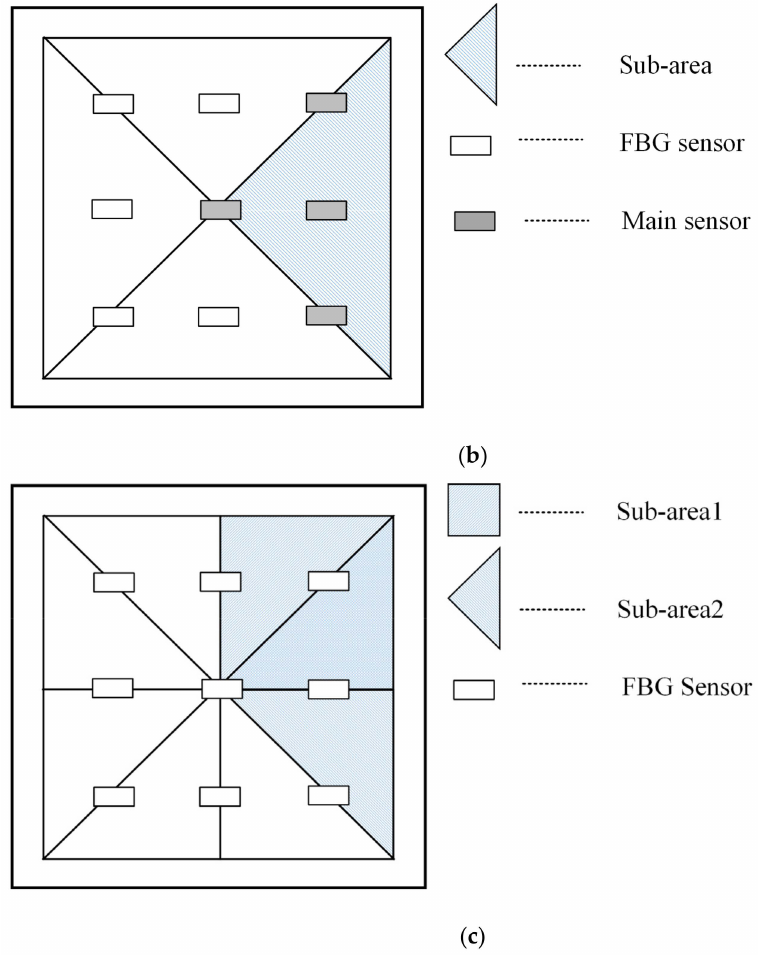
Figure 7. Division and sub-areas of the measurement area: ( a ) square mode; ( b ) triangle mode; ( c ) division mode in the proposed